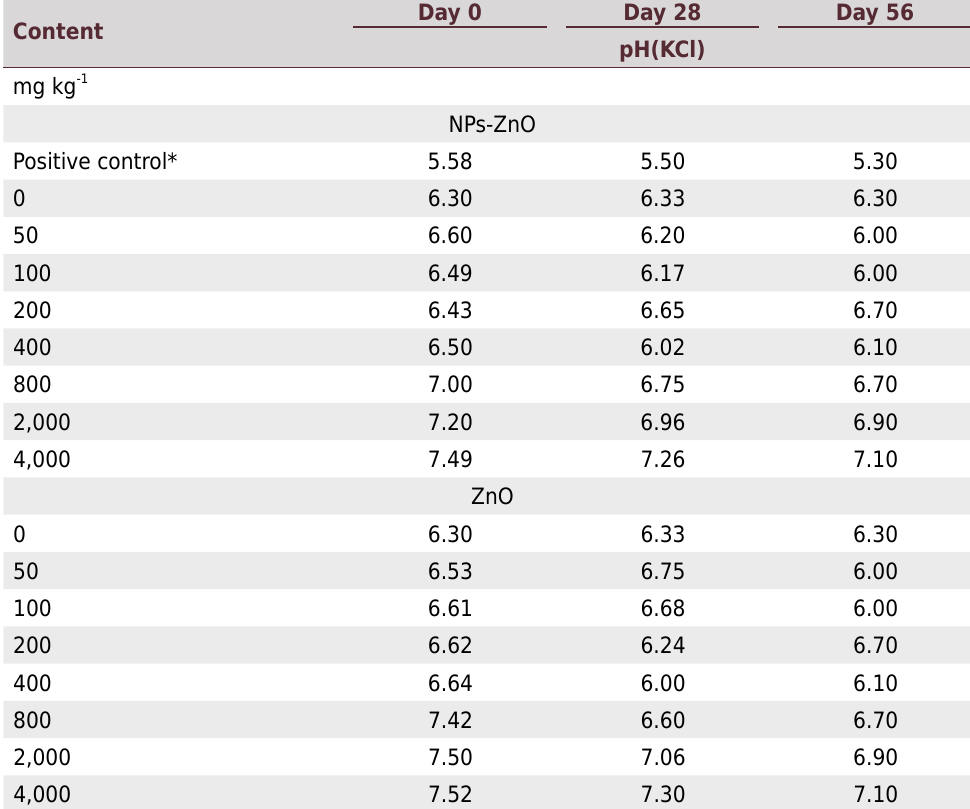
Table 1. Mean pH(KCl) readings obtained during E. andrei and F. candida reproduction tests in an Entisol contaminated with nanoparticles of zinc oxide (NPs-ZnO) and non-nano zinc oxide